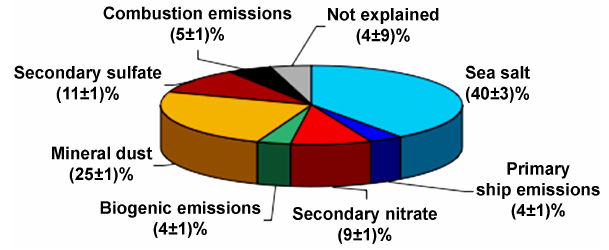
Figure 10. Relative annual contributions to the PM 10 concentration (average over the years